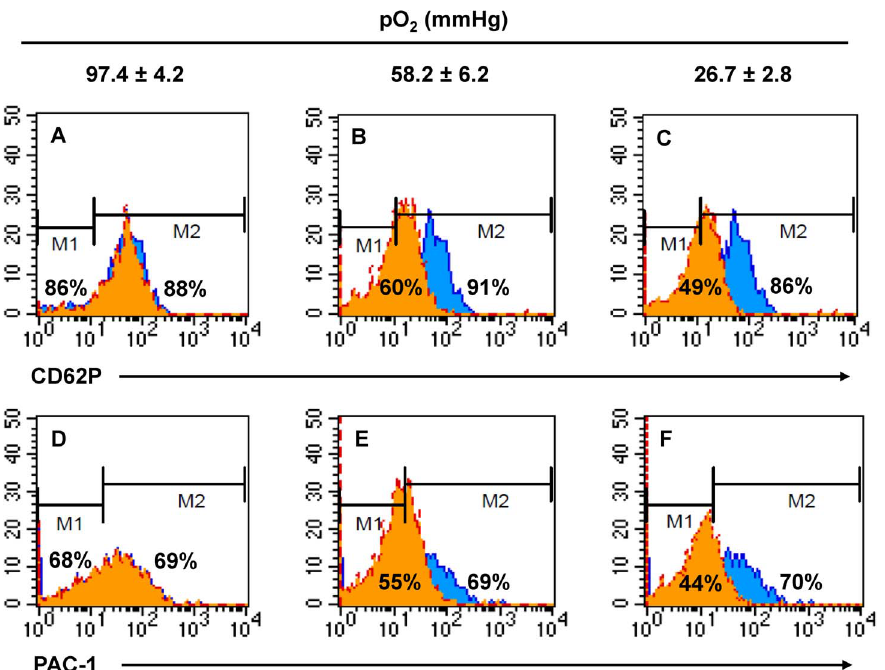
Figure 3. Nitrite inhibits thrombin-induced platelet activation in the presence of deoxygenated erythrocytes. Representative flow diagrams demonstrate the inhibitory effects of nitrite on the thrombin-induced activation of platelets. Platelet activation was analyzed by monitoring the percentage of cells expressing P-selectin (A, B, C) and activated gpIIb/IIIa (D, E, F) after thrombin (1 U/mL) stimulation in both control (blue) and nitrite (1 m M; orange) treated group in the presence of erythrocytes (Hct 42.6%) with different oxygen concentrations [pO 2 ; 97.4 6 4.2 mmHg